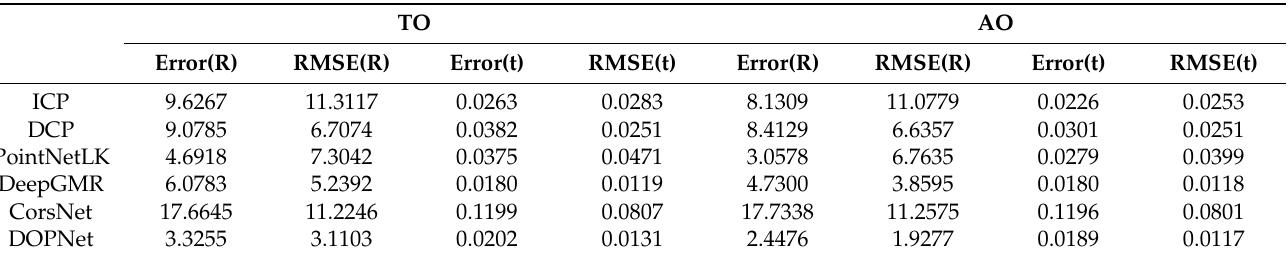
Table 5. Robustness against noise.